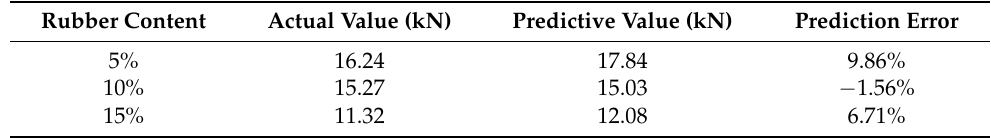
Table 6. Energy (3) single-parameter neural network prediction